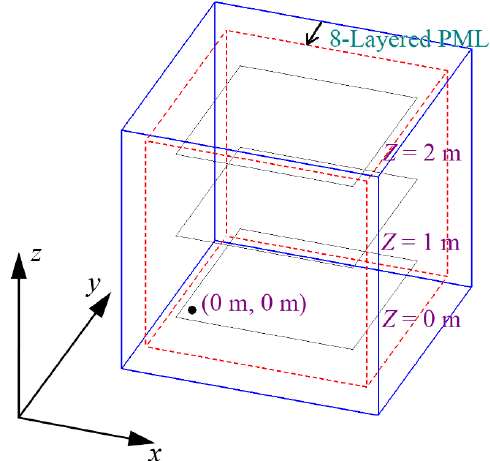
Figure 1. Diagram of 3D electric dipole radiation. the coordinate (0 m, 0 m, 0 m) is located at the near corner portions in the 3D space, the cross-sections Z = 0 m, 1 m, 2 m are, respectively, the observation planes during the electromagnetic transient process.